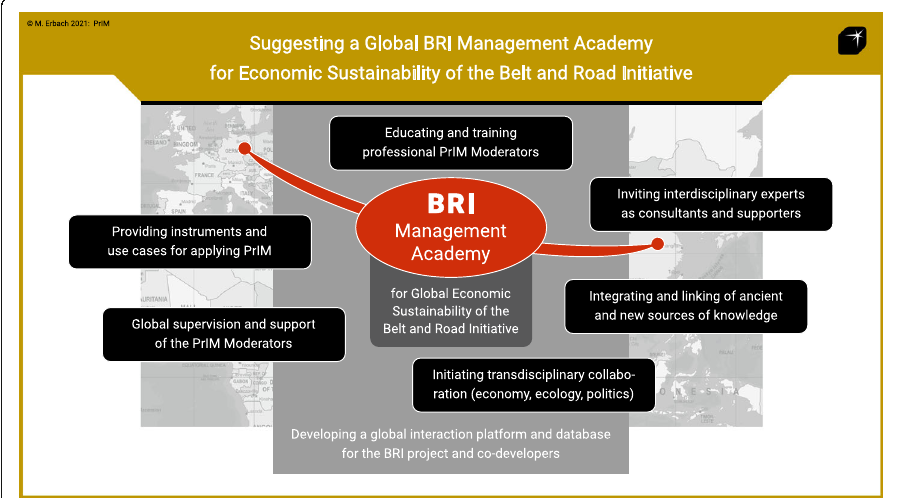
Fig. 10 The tasks of the BRI Management